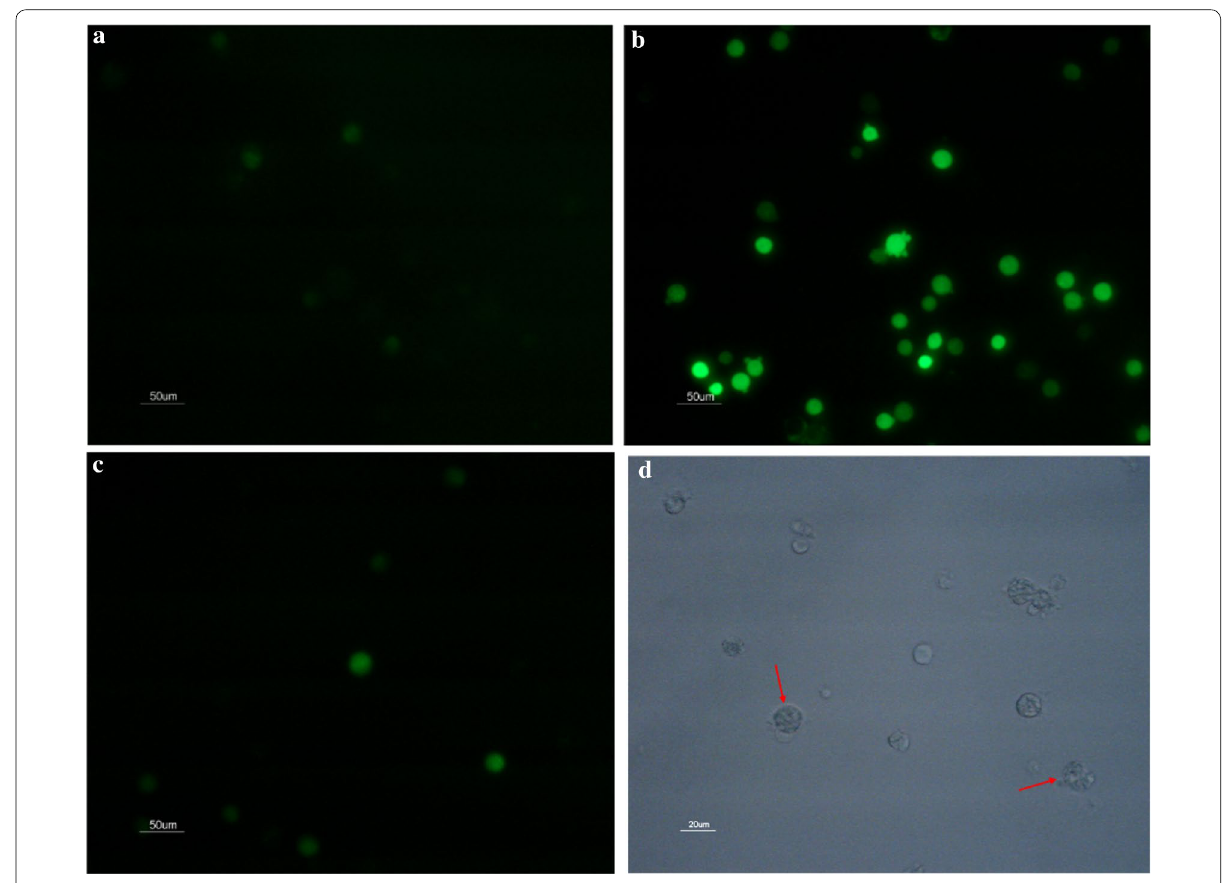
Fig. 6 Reactive oxygen species of K562 cells. a The control cells without lipopeptide treatment; b the cells treated with 65.76 μM lipopeptides for 48 h; c the treated cells with ROS inhibitor; the scale bar is 50 μm. a The morphology of cells treated with lipopeptides and ROS inhibitors; the scale bar is 20